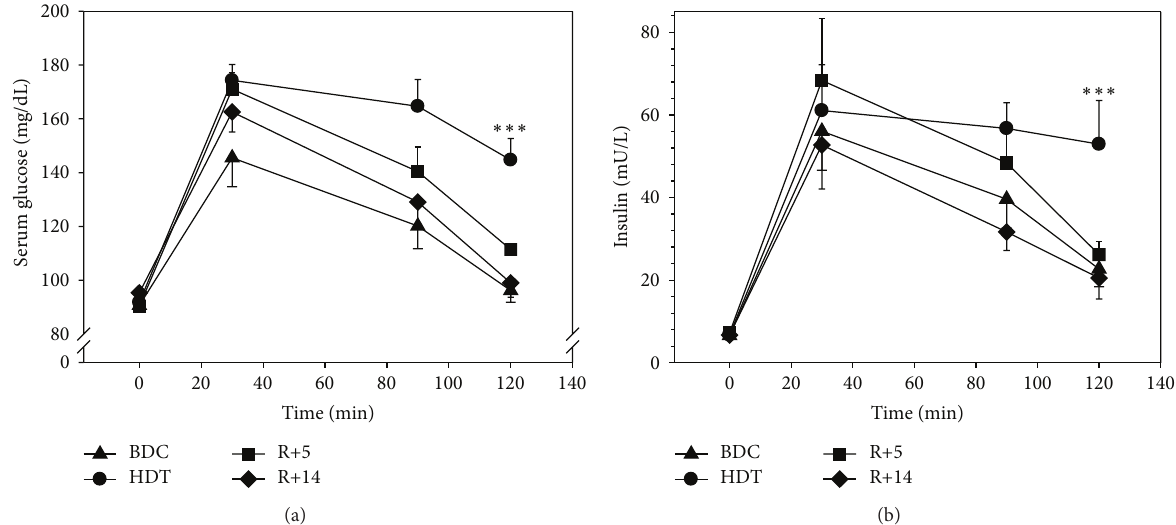
Figure 1: (a) Mean values and SEM of serum glucose concentrations following an oral glucose tolerance test during the in-house ambulatory phase (BDC), on day 21 in head-down tilt bed rest (HDT) and after 4 (R+5, in-house) and 13 (R+14) days of recovery. ∗∗∗ 𝑃 < 0.001 for the comparison of the prebed rest to bed rest. (b) Mean values of serum insulin concentrations following an oral glucose tolerance test on the identical days and points in time as glucose concentrations were analyzed. ∗∗∗ 𝑃 < 0.001 for the comparison of the prebed rest to bed rest.